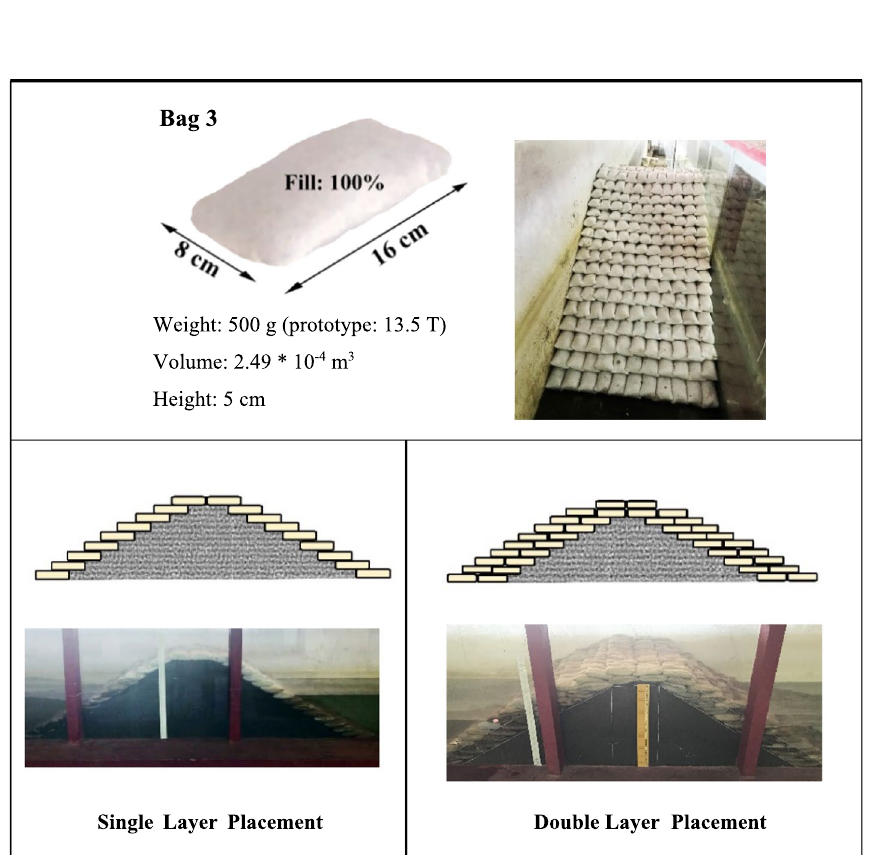
Figure 2. Dimensions and placement modes GSC units used in the model studies 30